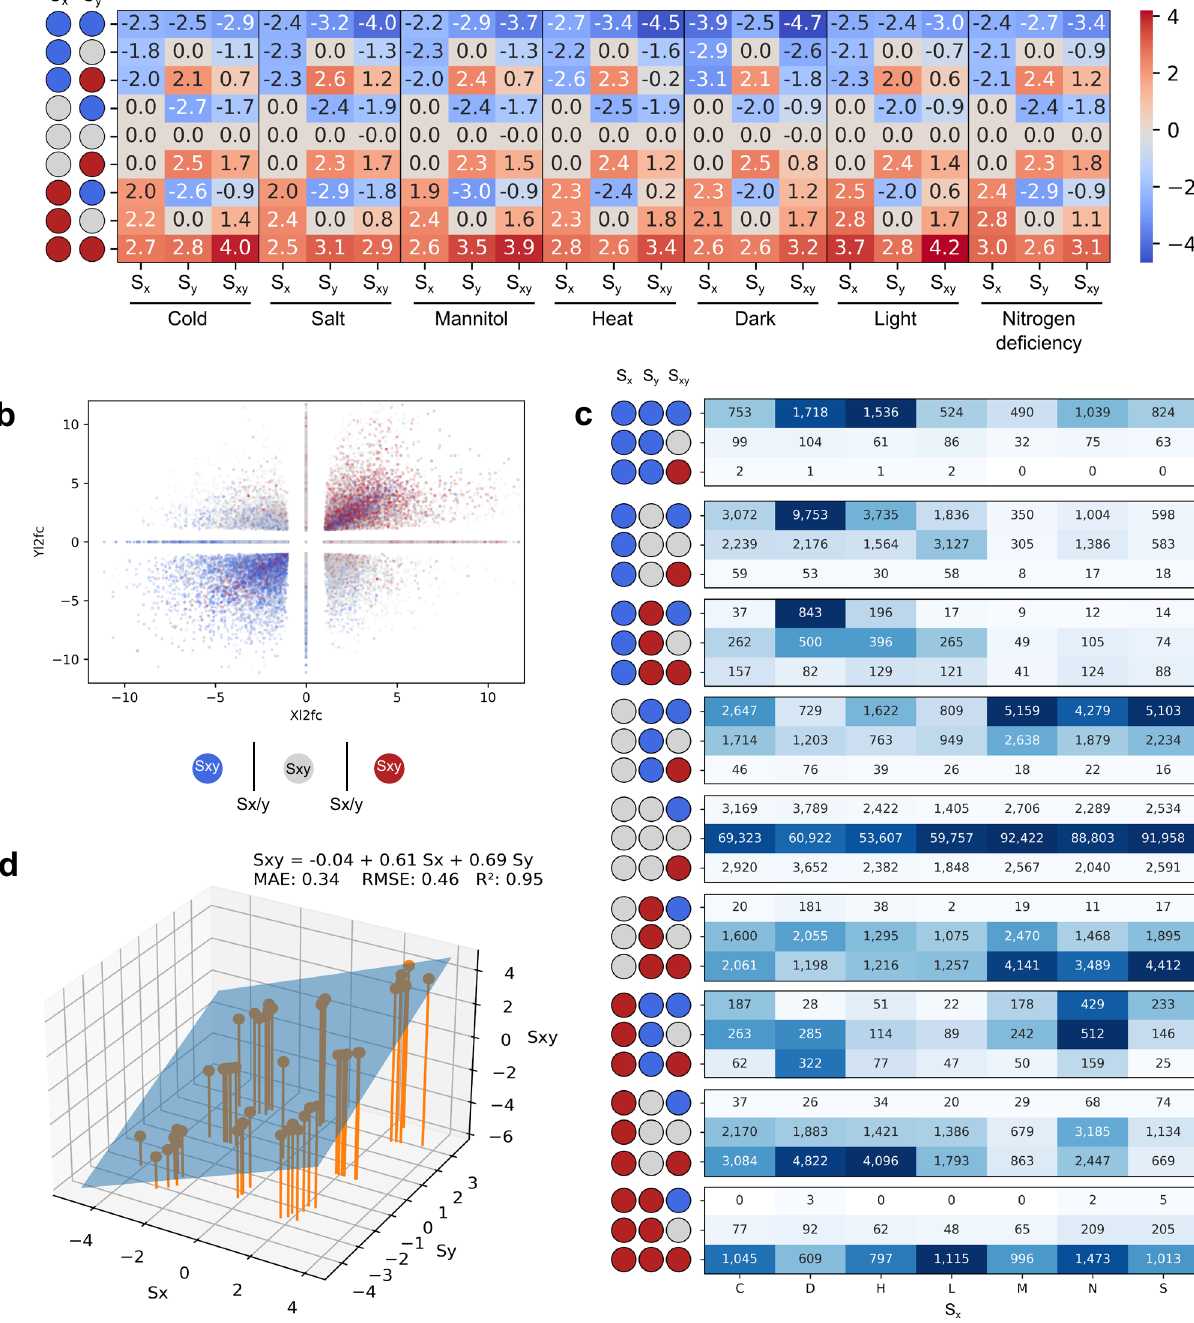
heatmapre fl ectstheproportionofeventsinagivenstress(column),andthecolors are normalized across each category of S x and S y . The actual number of observa- tions is annotated in the cells. Blue, red, and gray circles indicate genes that are signi fi cantly downregulated, upregulated, and not changed, respectively. d Linear regression of the average log2fc values from panel ( a ). The inferred formula is shown,togetherwithmeanabsoluteerror(MAE),rootmeansquarederror(RMSE), and R 2 (goodness-of- fi t